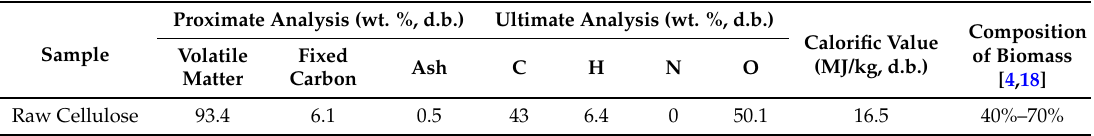
Table 1. Properties of cellulose. d.b.: Dry